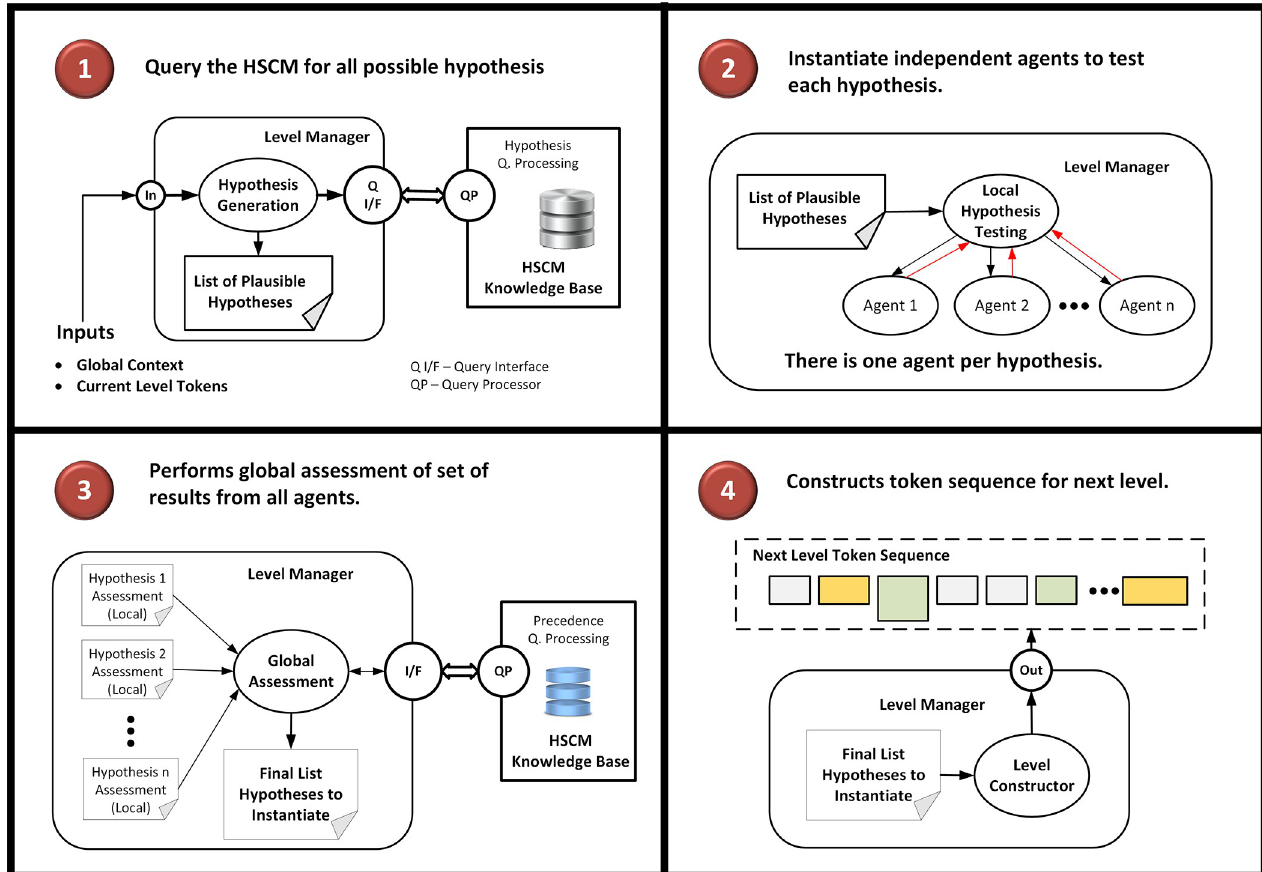
Fig 5. Internal processes initiated by the level manager within the parser execution process.